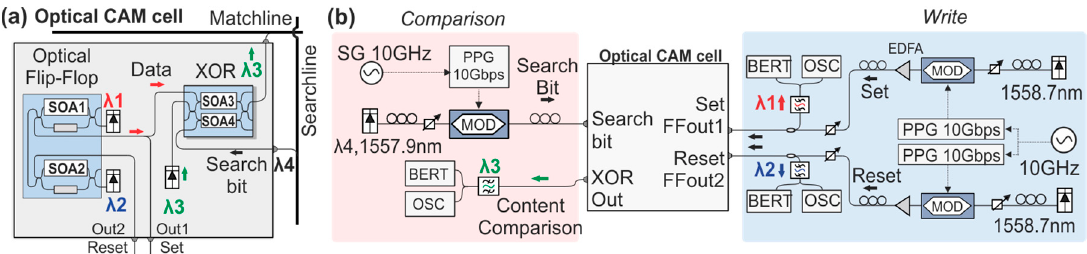
Figure 5. ( a ) Proposed architecture of an all-optical CAM cell; ( b ) Experimental setup for the demonstration of the Comparison operation and Write operation.